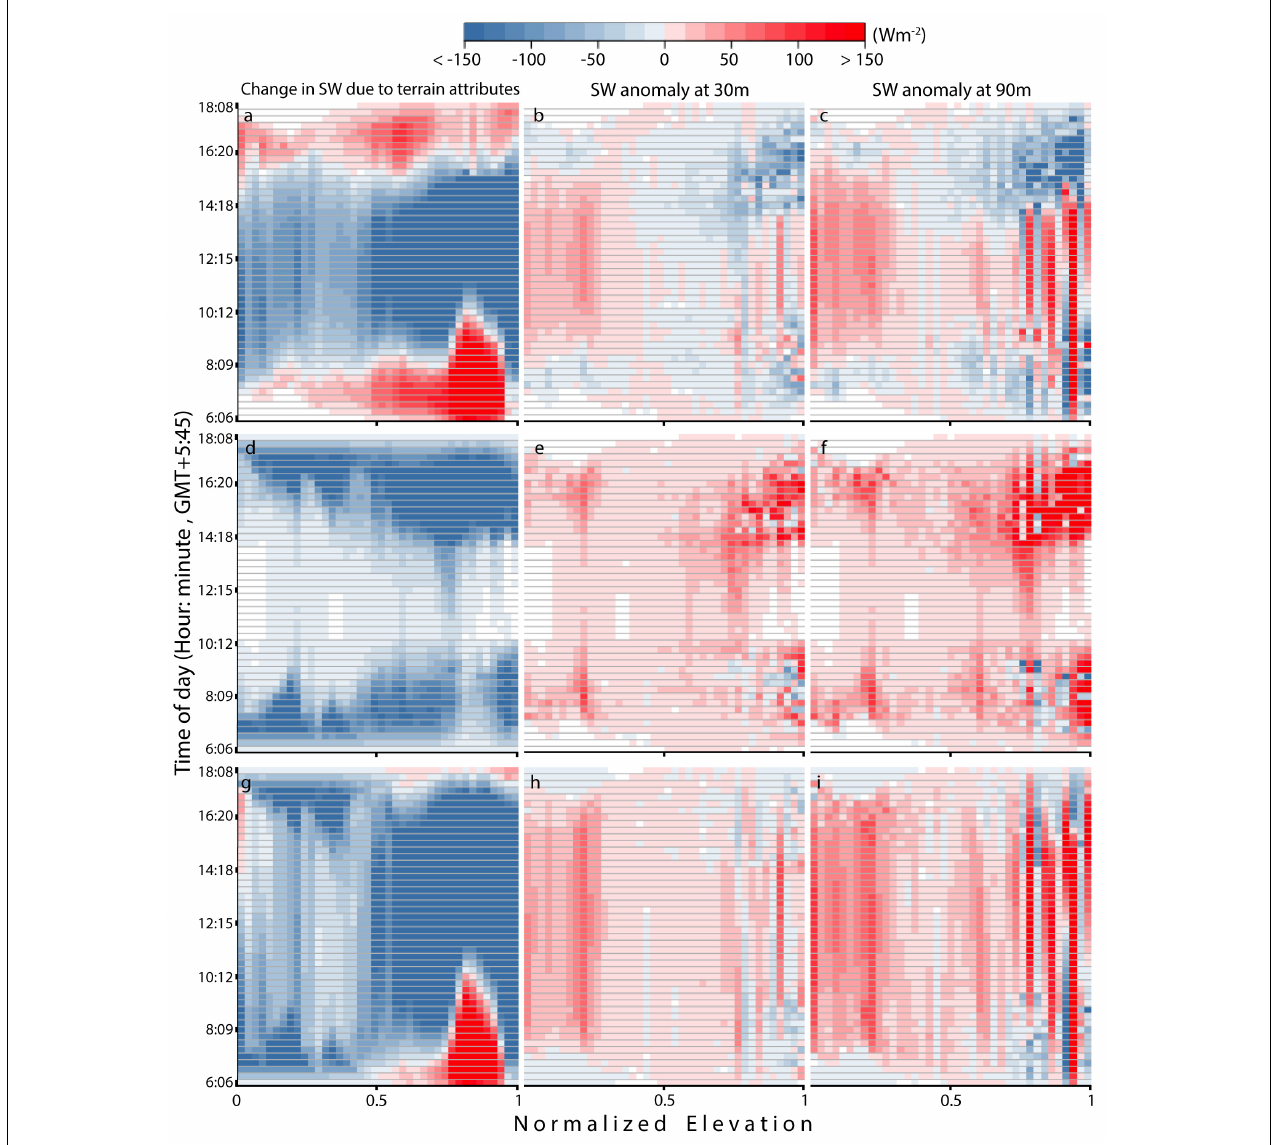
FIGURE 6 | Change in incident SW irradiance due to slope/aspect (a) for East Rongbuk Glacier (calculated with the 8-m HiMAT DEM). Sunrise (Sunset) occurs at 6:06 am (8:09 pm) local time on March 21, 2019 at this glacier. The y-axis shows the time stamp at 15 min intervals, starting at sunrise and ending at sunset. The anomaly (or bias) introduced by the change in slope/aspect when modeling SW irradiance at 30-m DEM resolution, as opposed to 8-m resolution (b) , and the bias added to slope/aspect from modeling at 90-m resolution (c) . The subsequent panel rows show the same change in irradiance and SW biases for topographic shading (d–f) and combined terrain attributes (g–i) . Values are aggregated into 50-m elevation bins and color scale changes in increments of ± 15 Wm − 2